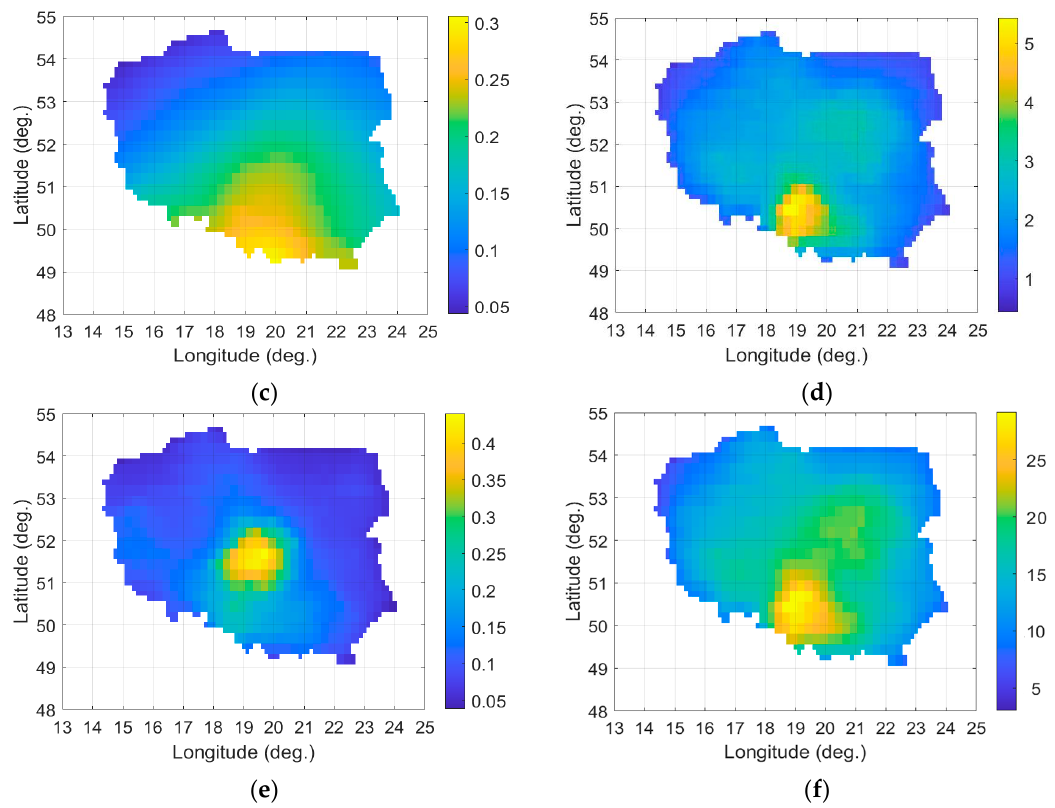
Figure 2. ( a ) The ambient PM2.5 concentration at surface level in 2015 based on the EMEP over Poland (µg·m − 3 ); ( b ) the difference between modelled ambient PM2.5 concentration at surface level in 2015 based on EMEP emission data and in 2050, where the emissions for the household and tertiary, road transport, and power sectors were applied according to the High-RES centralized scenario (µg·m − 3 ); ( c ) the difference between modelled ambient PM2.5 concentration at the surface level in 2015 based on EMEP emission data and in 2050, where the emissions for the power sector were applied according to the High-RES centralized scenario (µg·m − 3 ); ( d ) the difference between the modelled ambient PM2.5 concentration at the surface level in 2015 based on EMEP emission data and in 2050, where the emissions for the household and tertiary sector were applied according to the Mod-RES scenario (µg·m − 3 ); ( e ) the difference between the modelled ambient PM2.5 concentration at the surface level in 2015 based on EMEP emission data and in 2050, where the emissions for the road transport sector were applied according to the Mod-RES scenario (µg·m − 3 ); ( f ) the percentage change between the modelled ambient PM2.5 concentration at the surface level in 2015 based on EMEP emission data and in 2050, where the emissions for the household and tertiary, road transport, and power sectors were applied according to the High-RES centralized scenario (%). In Figure 2b–f, the higher the number the points, the greater the reduction.